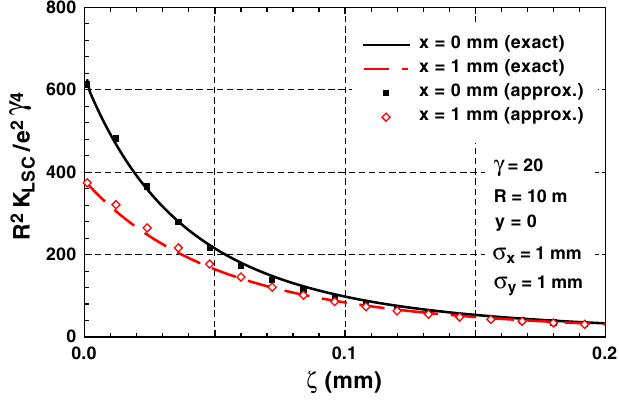
FIG. 4. (Color) Comparison between the approximation of Eq. (31) and an exact integration of Eq. (26) for a round